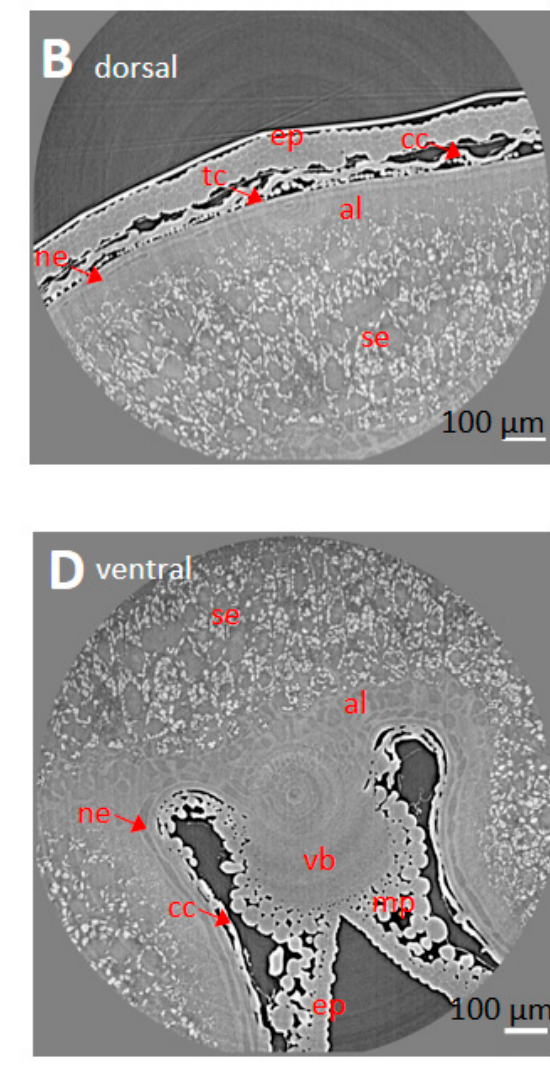
Figure 4. Spatial variability observed in different regions on a wheat section at the equatorial position. ( A ) Regions targeted for high-resolution X-ray µCT on a transverse section. ( B – D ) Representative tomography image in dorsal ( B ), lobe ( C ), and ventral ( D ) regions of a wheat caryopsis harvested at 250 °DAA. Legend: mp—mesocarp; cc—cross cells; tc—tube cells; ep—epicarp; vb—vascular bundle; se—starchy endosperm; ne—nucellar epidermis; al—aleurone.